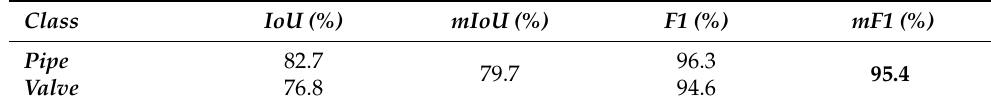
Table 4. DGCNN instance-level metrics on T EXTRA test set.